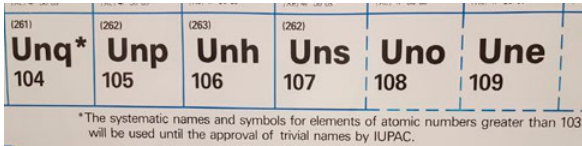
Figure 5. Detail from a 1985 German periodic table (VCH Ver- lagsgesellschaft) showing multiple names for elements 104 and 105 (Original courtesy of the Science History Institute, Philadelphia, PA, https://digital.sciencehistory.org/works/k3569525k).